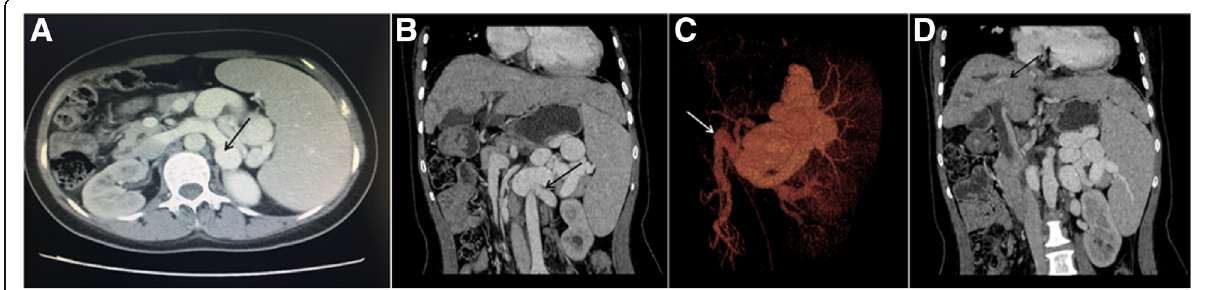
Fig. 1 Axial, coronal and three-dimensional CT images show type II Abernethy malformation in the patient. ( a and b ) A side-to-side shunt between the splenic vein and the left renal vein is visible in axial and coronal CT images (black arrow). c 3D vessel reconstruction shows a normal main portal vein formed from the splenic and superior mesenteric veins (arrow). d The portal vein appears slender in the coronal CT image